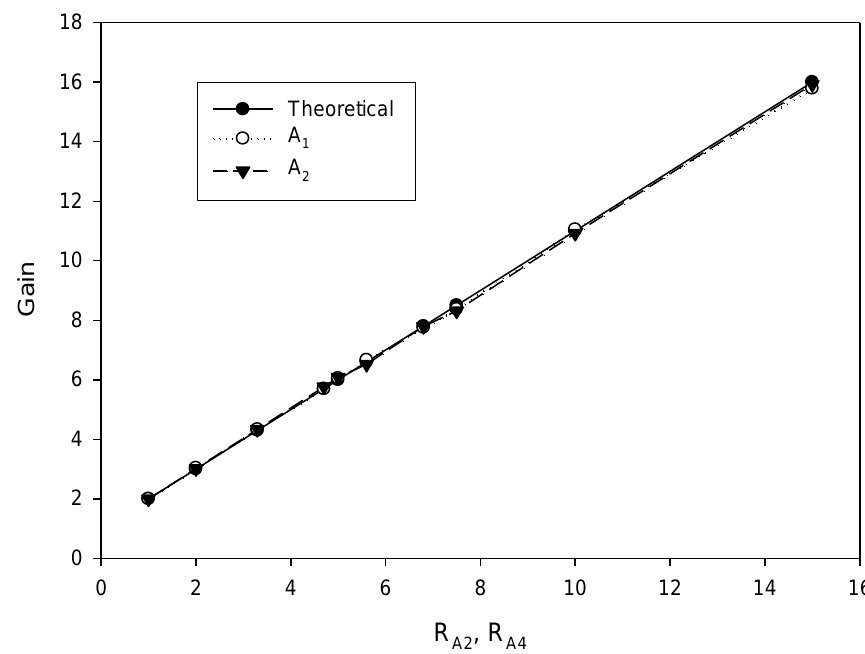
Figure 16. The voltage gains as a function of the resistors R A2 and R A4 .